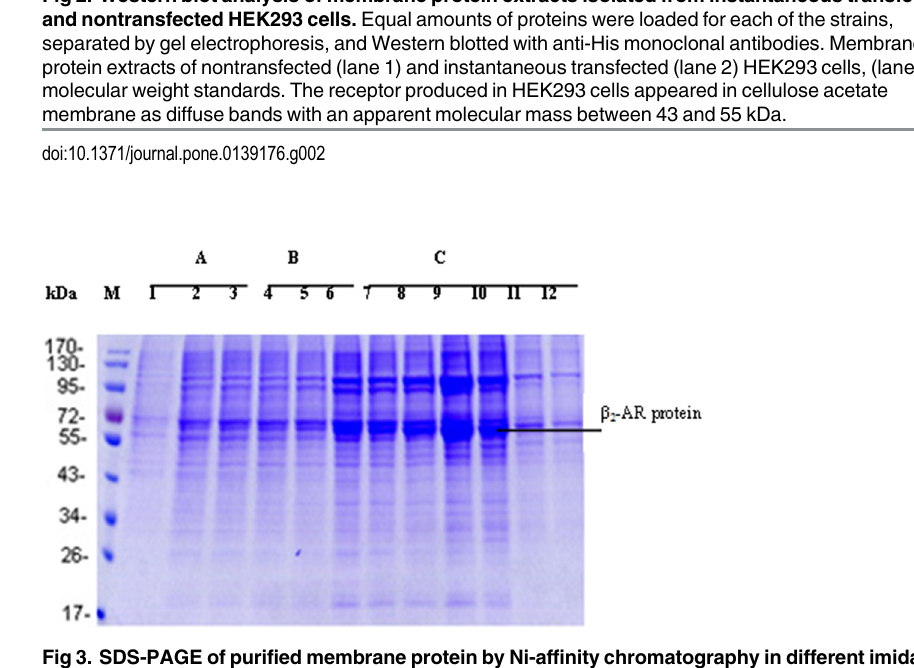
Fig 3. SDS-PAGE of purified membrane protein by Ni-affinity chromatography in different imidazole concentration. The imidazole concentration in the elution buffer was optimized at 3 levels: 75 (A), 125 (B), and 250 Mm (C). When it reached 250 mM, the eluate in 7-10 tubes contained abundant recombinant β 2 -AR protein.